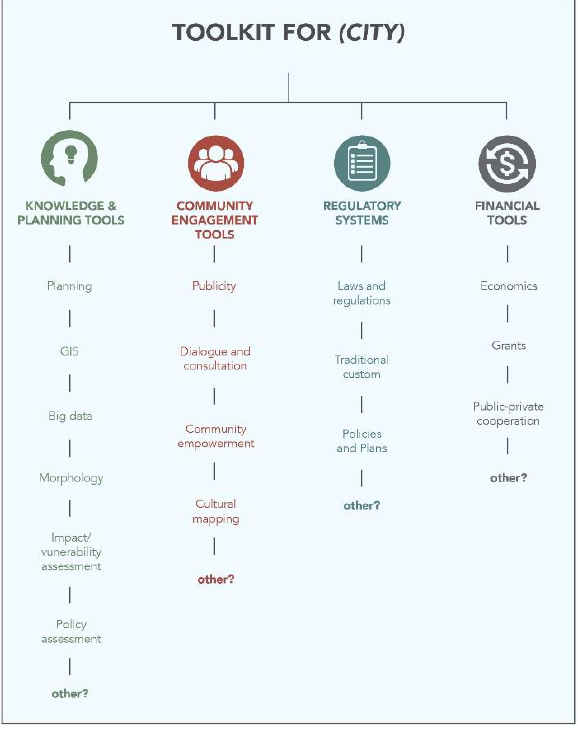
Figure 1. Toolkit for the city, Source: The HUL Guidebook.